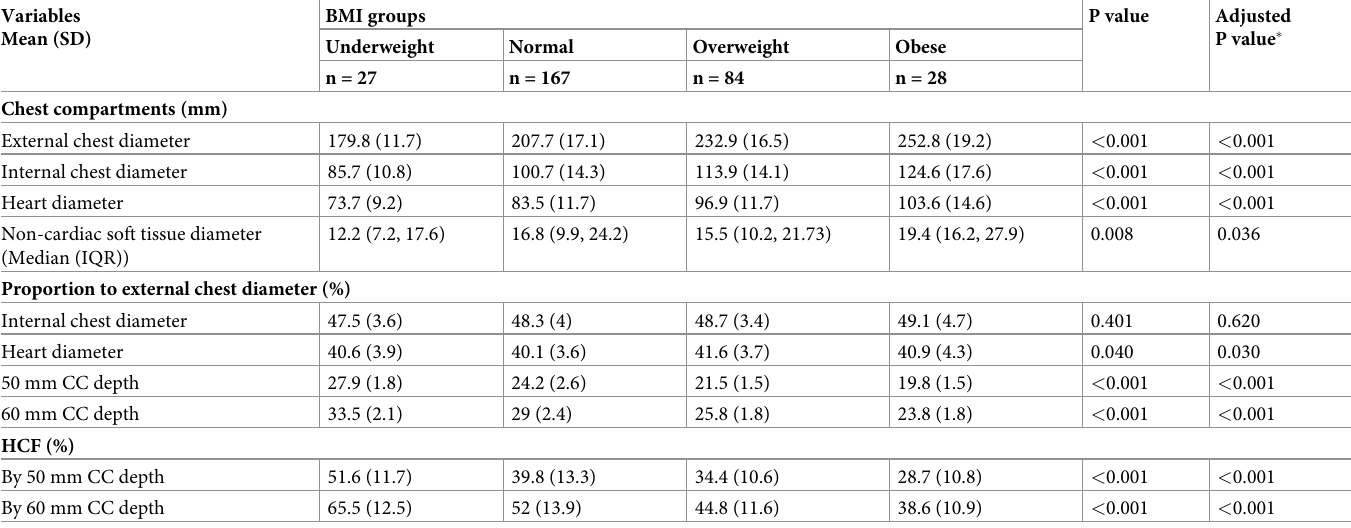
Table 4. Chest compartments, the proportion of chest compartments to external chest diameter and HCF, based on BMI indicates body mass index, CC; chest com- pression, HCF; heart compression fraction, mm; millimeter and SD: Standard